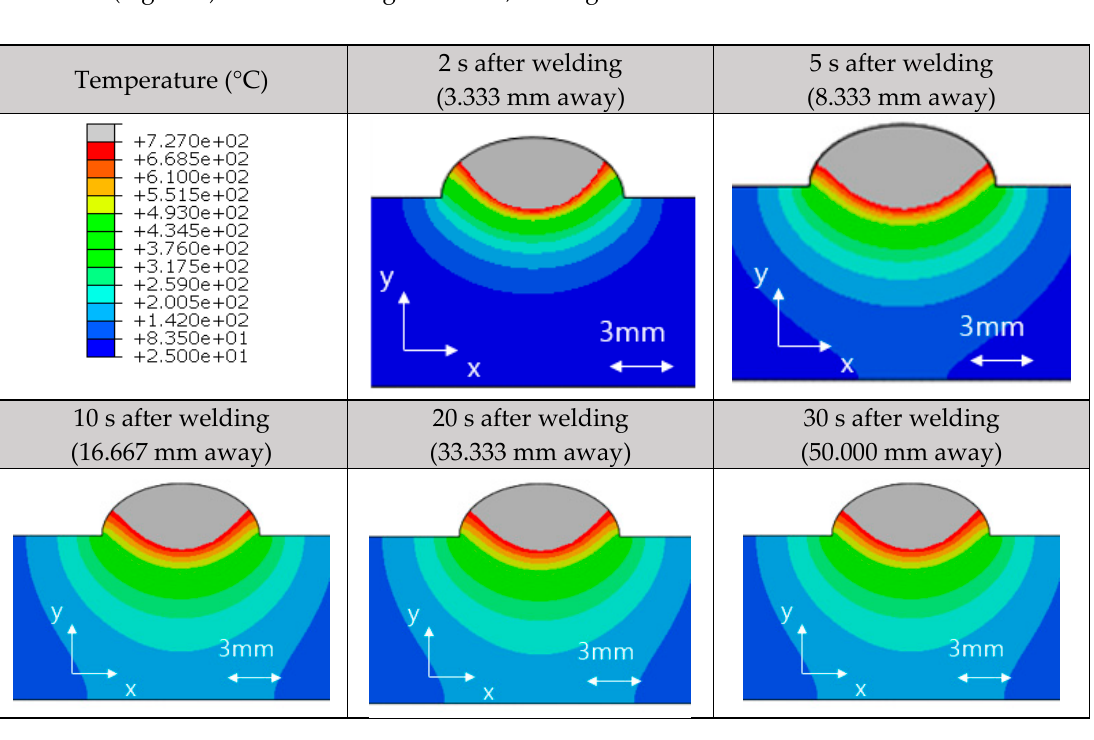
Figure 9. Temperature distribution in the cross-section (under the heat source).